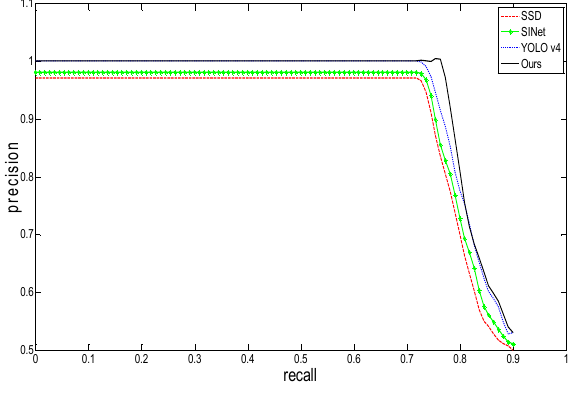
Figure 8. P-R curves for di ff erent models.